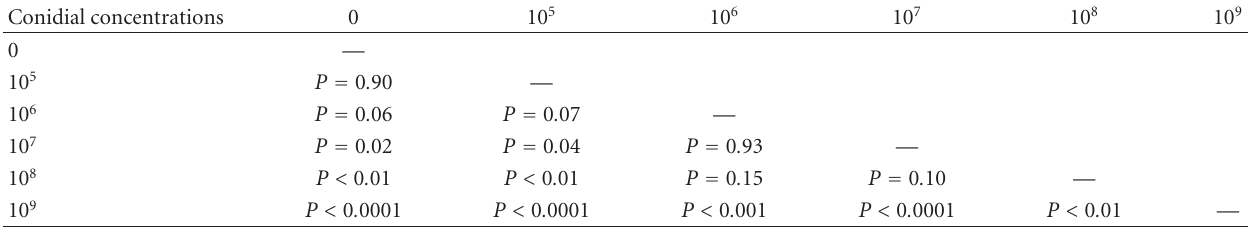
Table 2: P values of Log-rank test to compare two Kaplan-Meier survival curves for Atta bisphaerica workers treated with di ff erent conidial concentrations of Aspergillus ochraceus . P values less than 0.05 were considered significant.